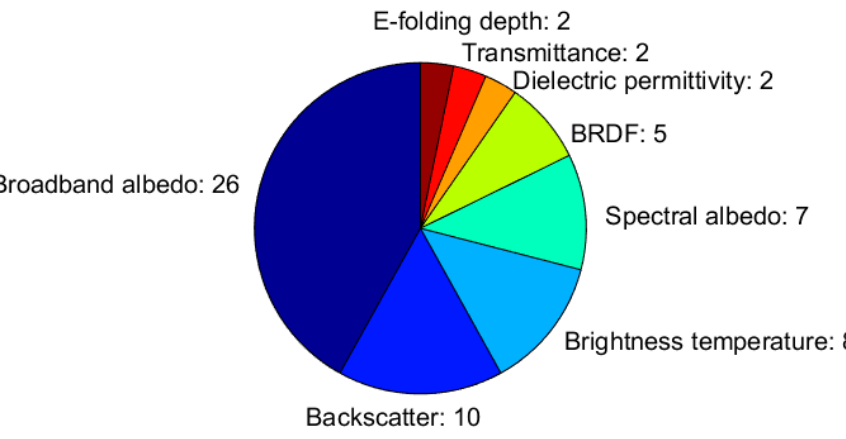
Figure 10. Measured snow electromagnetic properties. The width of each slice corresponds to the fraction each snow electromagnetic property has, relative to the total number of reported electromagnetic properties (i.e., the sum of the numbers given in the figure).